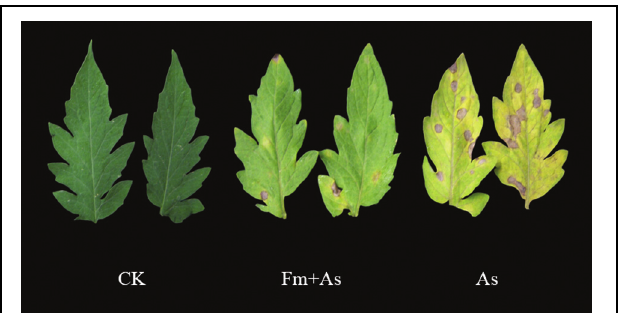
FIGURE 1 | Disease symptoms of early blight in leaves of tomato plants with or without mycorrhizal colonization by Funneliformis mosseae. The photos were taken 10 days after pathogen inoculation by Alternaria solani . Three treatments included: (1) CK: control plants without pathogen and mycorrhizal inoculation; (2) As: plants inoculated with A . solani only; (3) Fm + As: plants inoculated with both F. mosseae and A . solani .